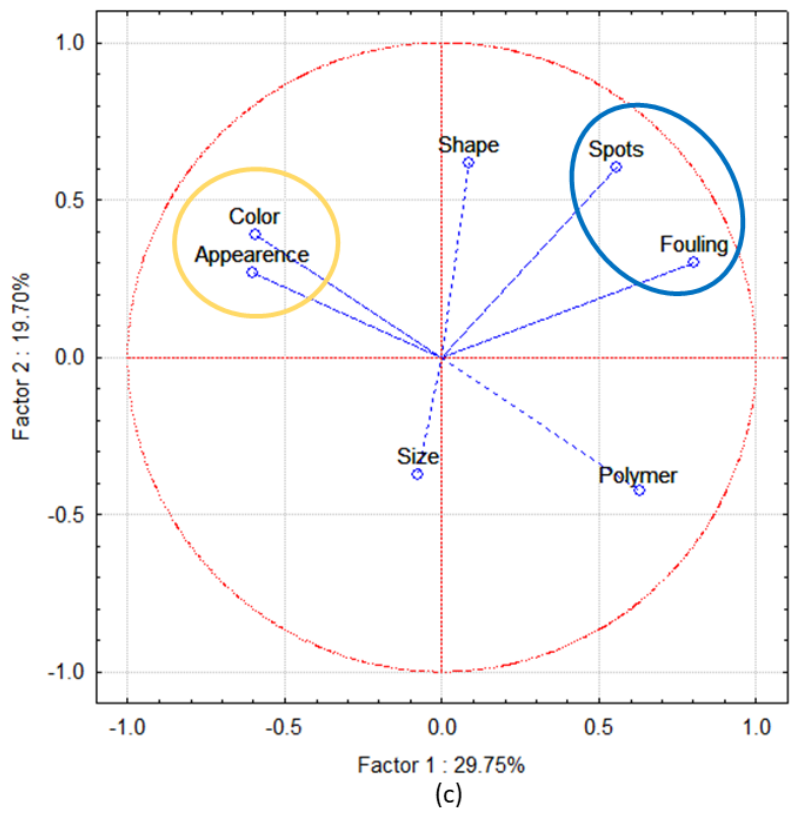
Figure 4. Principal component analysis (Factor 1 vs. Factor 2) of the pellets recovered from the beaches of ( a ) Le Grazie, ( b ) Calambrone and ( c ) Marina di Pisa.